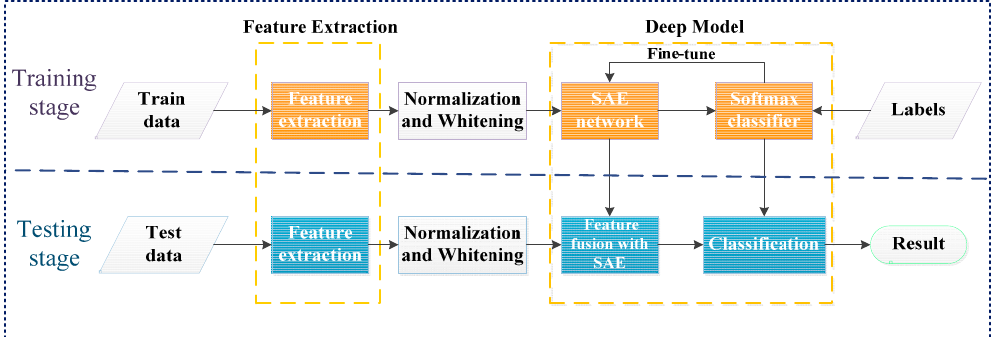
Figure 1. The feature fusion flowchart.